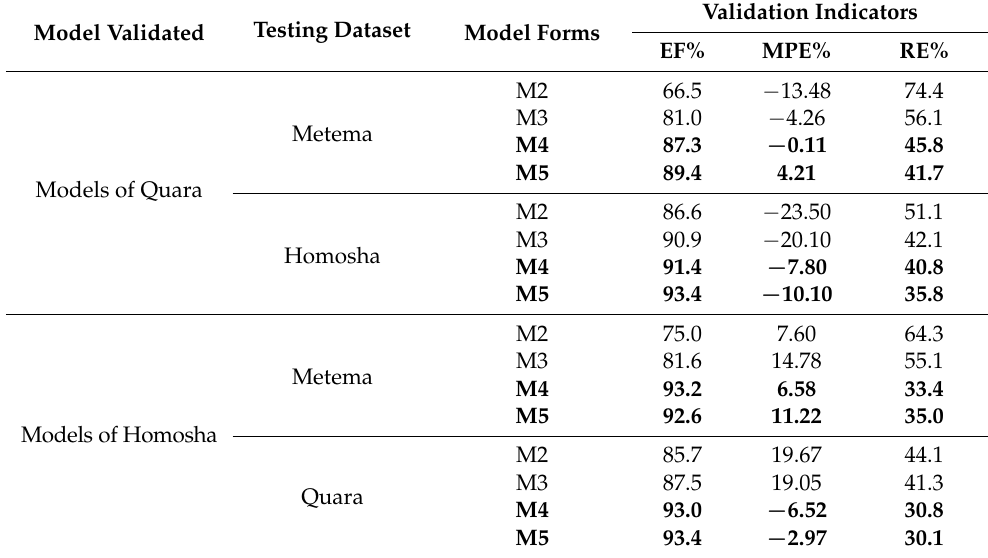
Figure 3. Validation results: the relative errors against the best models of estimated aboveground biomass (AGB in kg) when the models of a given site were applied for other sites. The symbols of white and black dotes refer to the validated models 4 and 5, respectively. Table 3. The performance of mixed-species models and their validation indicators over the testing dataset. The bolded model forms indicate the best-performing models over the testing dataset.